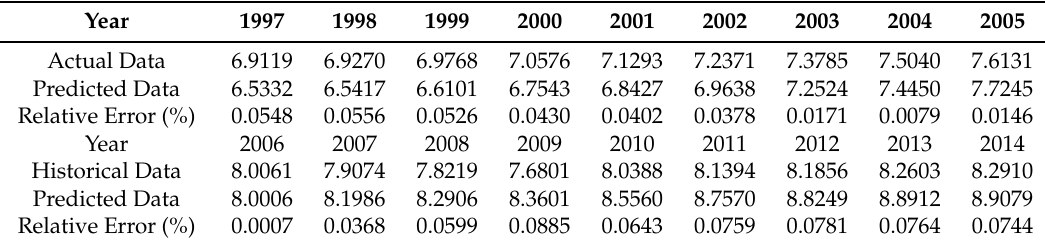
Table 4. Forecasting results and errors (%) (data in LN